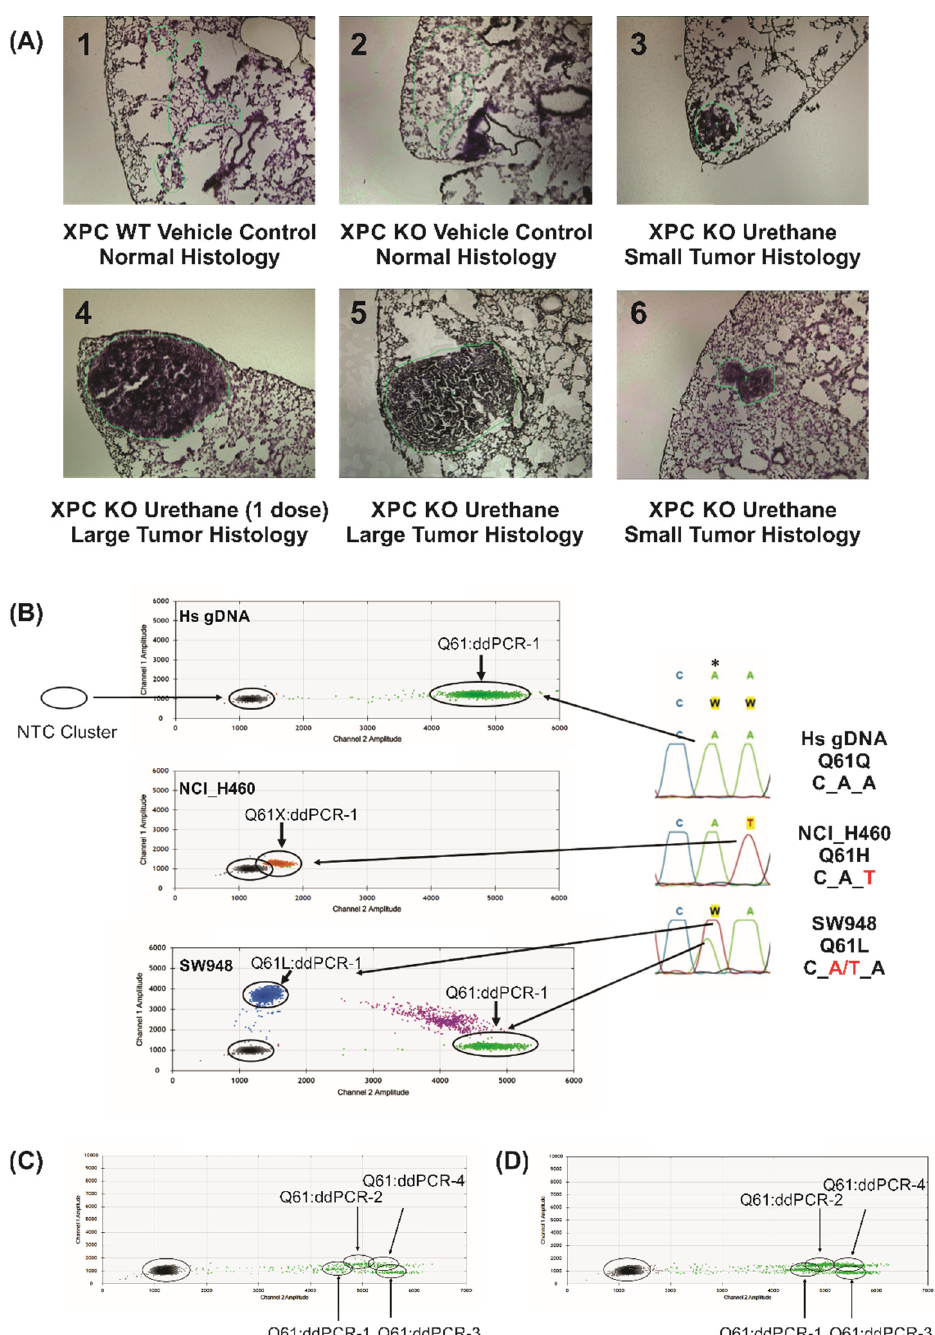
Figure 1. Differentiation of Kras Q61 mutants using digital droplet PCR. ( A ) Arcturus stained fresh- frozen lung slices of LCM samples used for this study, ranging from normal histology to large tumors, labelled 1A-1 to 1A-6 as indicated. 50 × total magnification. ( B ) Sanger sequencing traces (right) of human gDNA from control and cancer cell lines (NCI-H460 and SW948) tested with the ddPCR-1 (Q61L) primer/probe assay. Homozygous WT Kras (Q61) was detected in control human gDNA (green, top). Expected mutations were found by ddPCR-1 assay in NCI-H460 (homozygous Q61H, CAt), which identified an aberrant ddPCR signal caused by a nearby unidentified mismatch Kras sequence (orange, middle). SW948 (heterozygous Q61L, CwA, w = A/T) showed both WT Kras (green, CAA) and mutant Kras Q61L (blue, CTA). Purple dots identify double-labelled droplets due to high gDNA input (not detected at significant levels using LCM gDNA inputs of 5–20ng amplified gDNA). ( C ) All four Kras Q61 ddPCR assays on LCM control normal sample 1A-1 (Xpc WT vehicle control), showing only WT Kras Q61 without mutations (CAA sequence). ( D ) All four Kras Q61 ddPCR assays on sample 1A-2 (LCM Xpc-/-, vehicle control), again showing only WT Kras Q61.